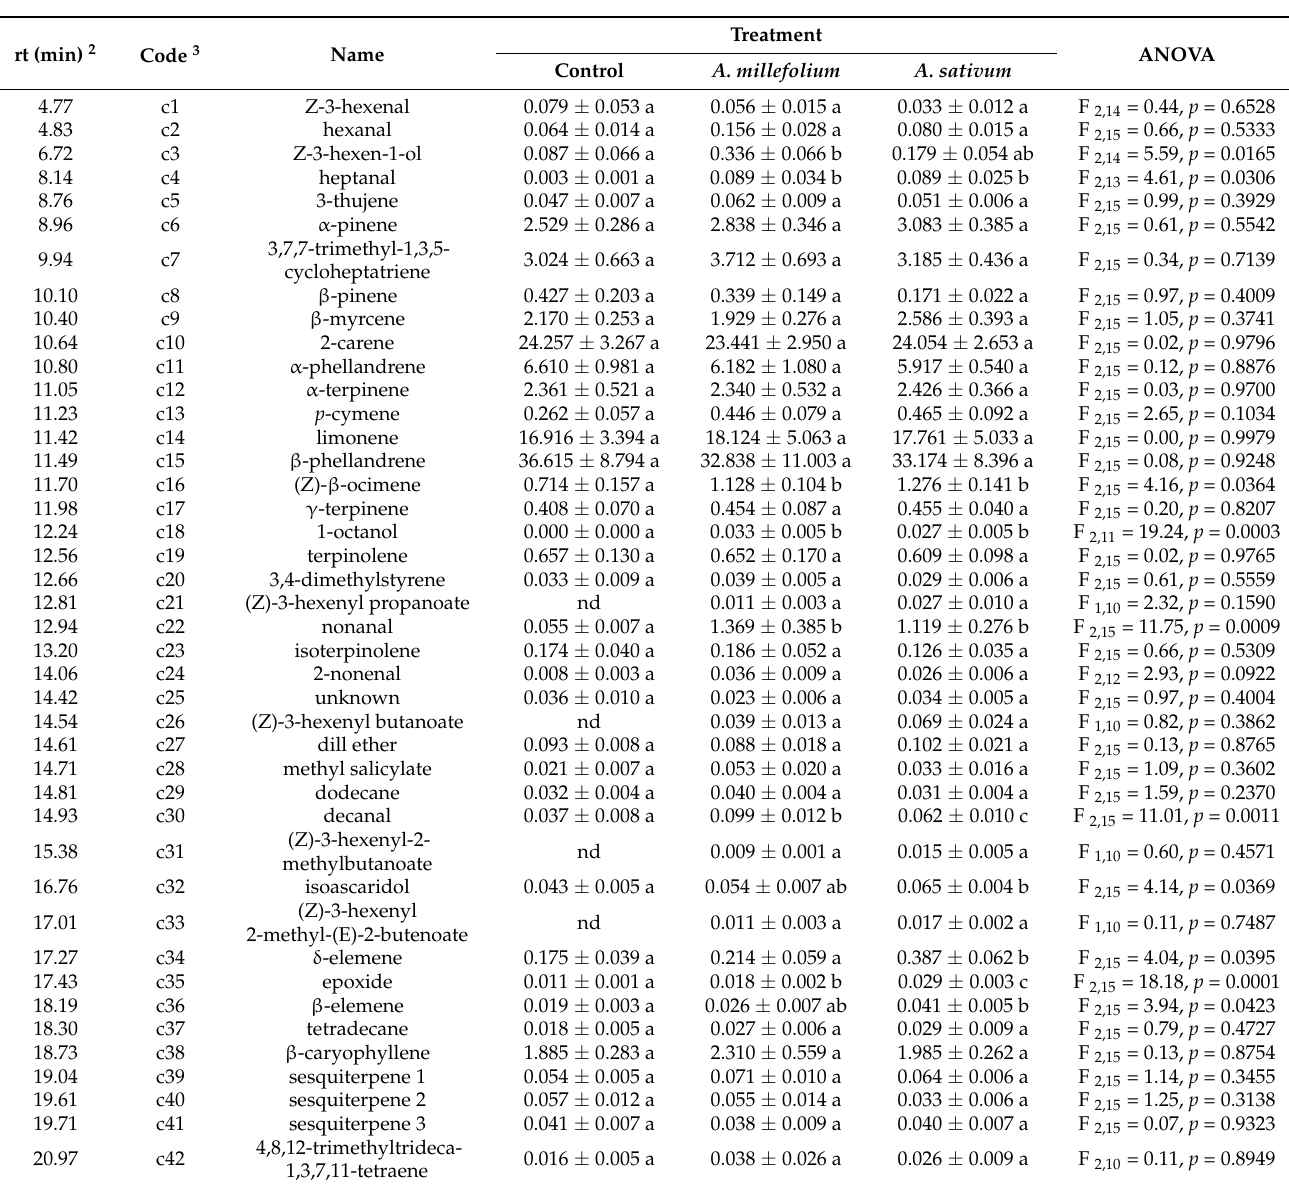
Table 1. Volatile compounds detected in samples of tomato plants treated with essential oils of